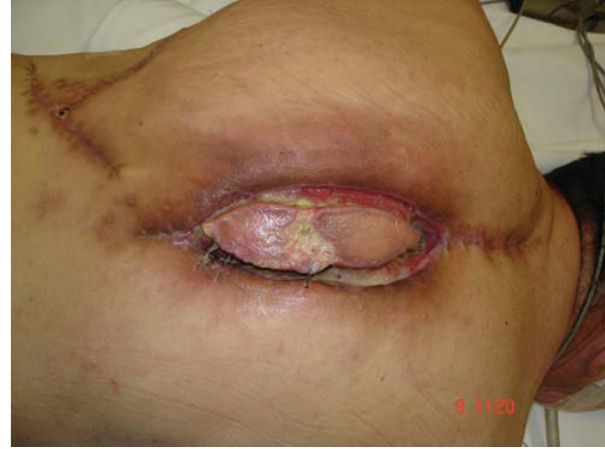
Figure 2 - The left latissimus dorsi was elevated with a transversely oriented skin paddle at the distal tip of the muscle